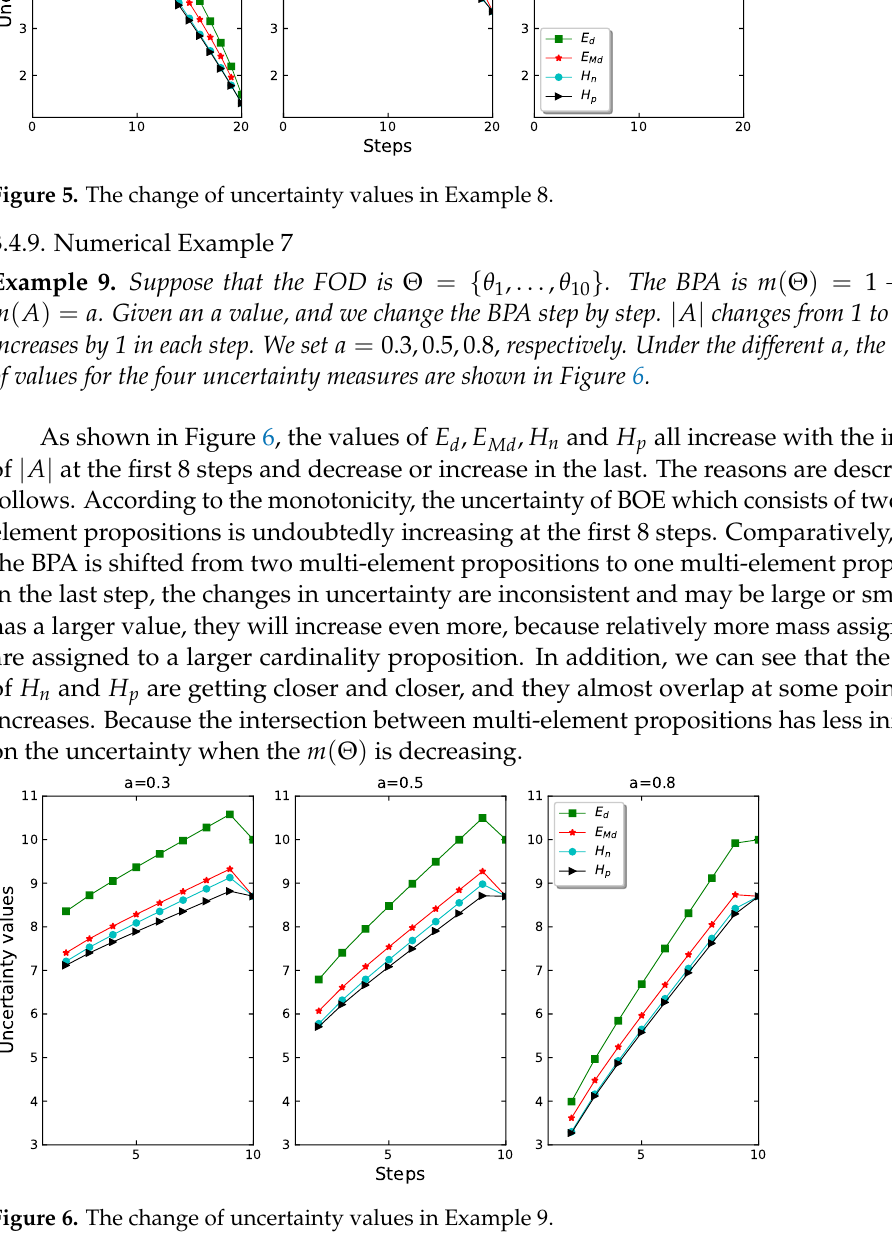
Figure 6. The change of uncertainty values in Example